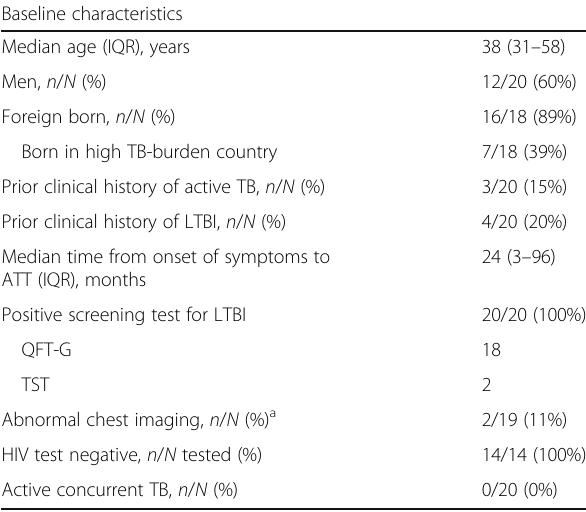
Table 1 Demographic and clinical characteristics of patients diagnosed with tuberculous uveitis Baseline